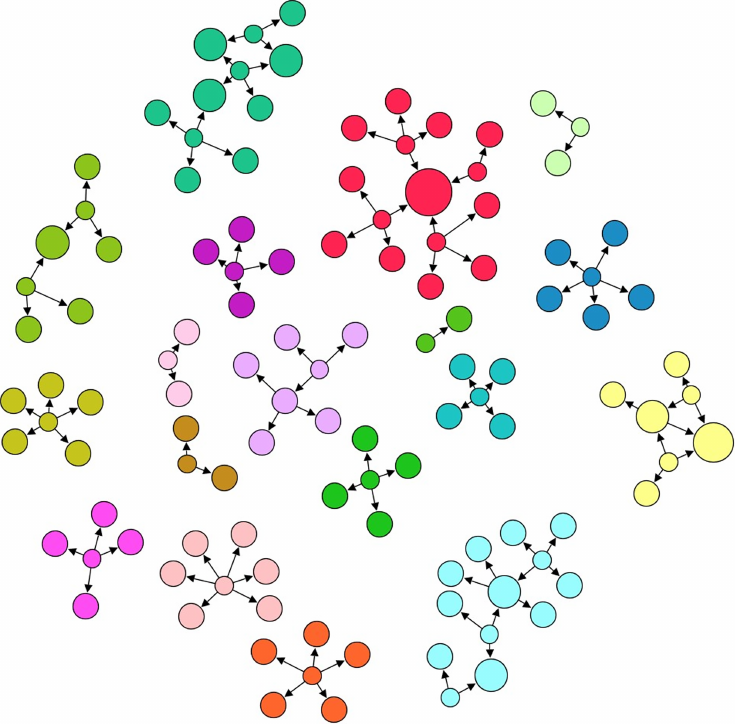
Fig 5. Representation of the givers’ personal trust networks. The node size refers to the in-degree level (that means the number of trusters of each node). Arrows go from givers nodes to their trustees.